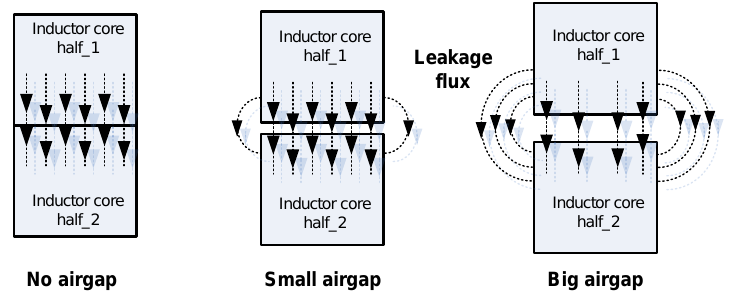
Figure 1. Representation of the magnetic core without air gap ( left ), with small air gap ( middle ), and with large air gap ( right ).